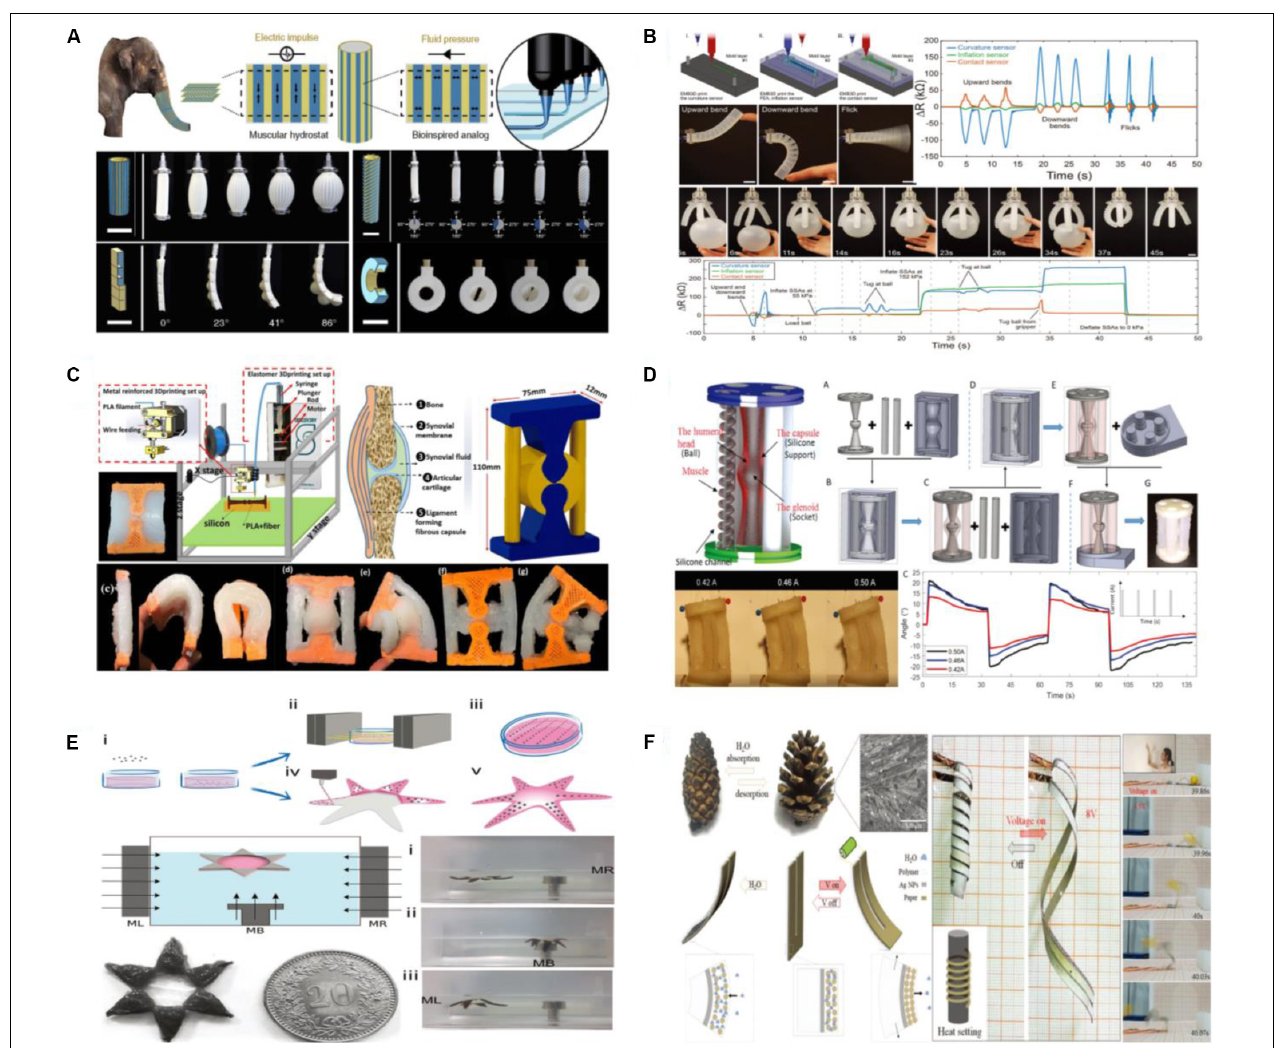
FIGURE 8 | (A) Soft actuators inspired by multilamellar fiber architecture and functional principle of the elephant trunk (Schaffner et al., 2018). Reproduced with the permission of Nature Communications. (B) Soft somatosensitive actuators with multiple conductive features fabricated by embedded 3D printing technology (Truby et al., 2017). Reproduced with the permission of 2018 WILEY-VCH Verlag GmbH & Co. KGaA, Weinheim. (C,D) Bioinspired joint system and musculoskeletal system (Hamidi and Tadesse, 2018; Wu et al., 2018). Reproduced with the permission of 208 Elsevier Ltd, 2018 WILEY-VCH Verlag GmbH & Co. KGaA, Weinheim. (E) Magnetism-induced shape-changing structures (Tognato et al., 2019). Reproduced with the permission of 2018 WILEY-VCH Verlag GmbH & Co. KGaA, Weinheim. (F) Electrically driven paper-based bilayer actuator (Hu et al., 2019). Reproduced with the permission of 2019 WILEY-VCH Verlag GmbH & Co. KGaA,